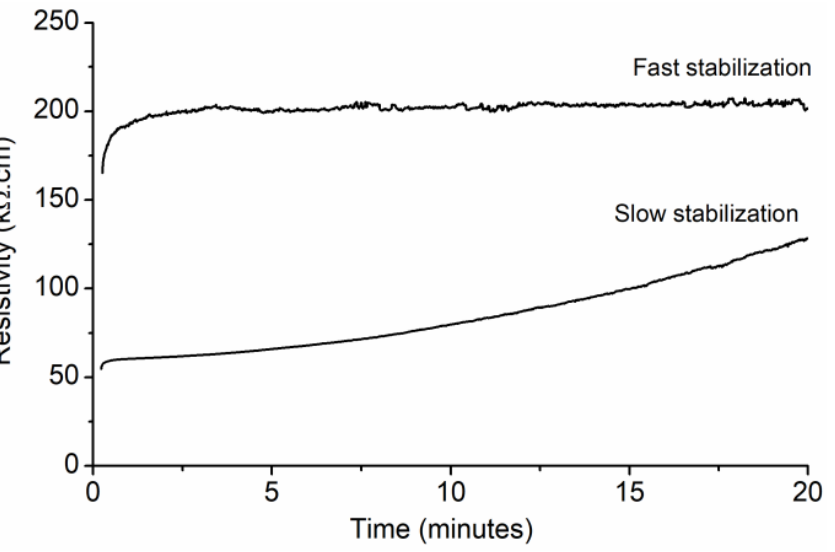
Figure 8. Typical electrical resistivity results over time obtained for CNT–cement composites. The stabilization time between 4 and 20 min of constant voltage application,